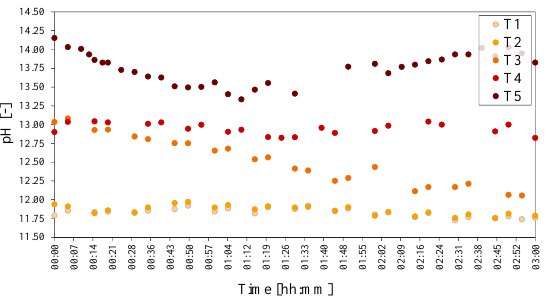
Figure 7. pHs of the temperature series of LDHs T1 = 20 ◦ C, T2 = 40 ◦ C, T3 = 60 ◦ C, T4 = 80 ◦ C and T5 = 90 ◦ C. The pH was adjusted to 25 ◦ C to facilitate comparison.